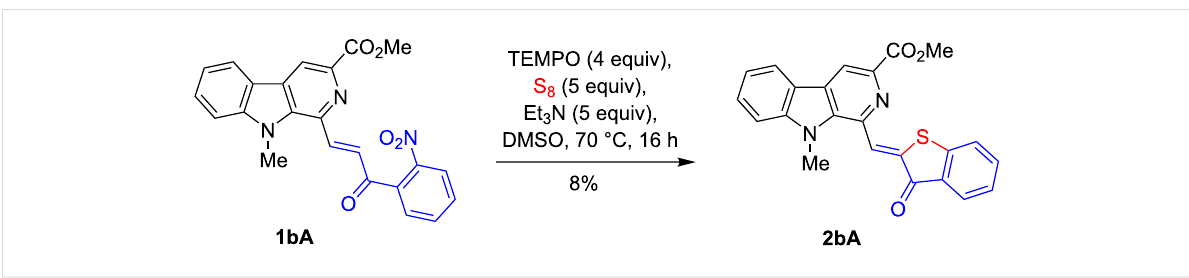
Based on our observations during the present study and previous reports [69], a plausible mechanism for the formation of the benzothiophenone ring is depicted in Figure 2. It is antici- pated that an initial formation of trisulfur radical anion (S 3 · − )